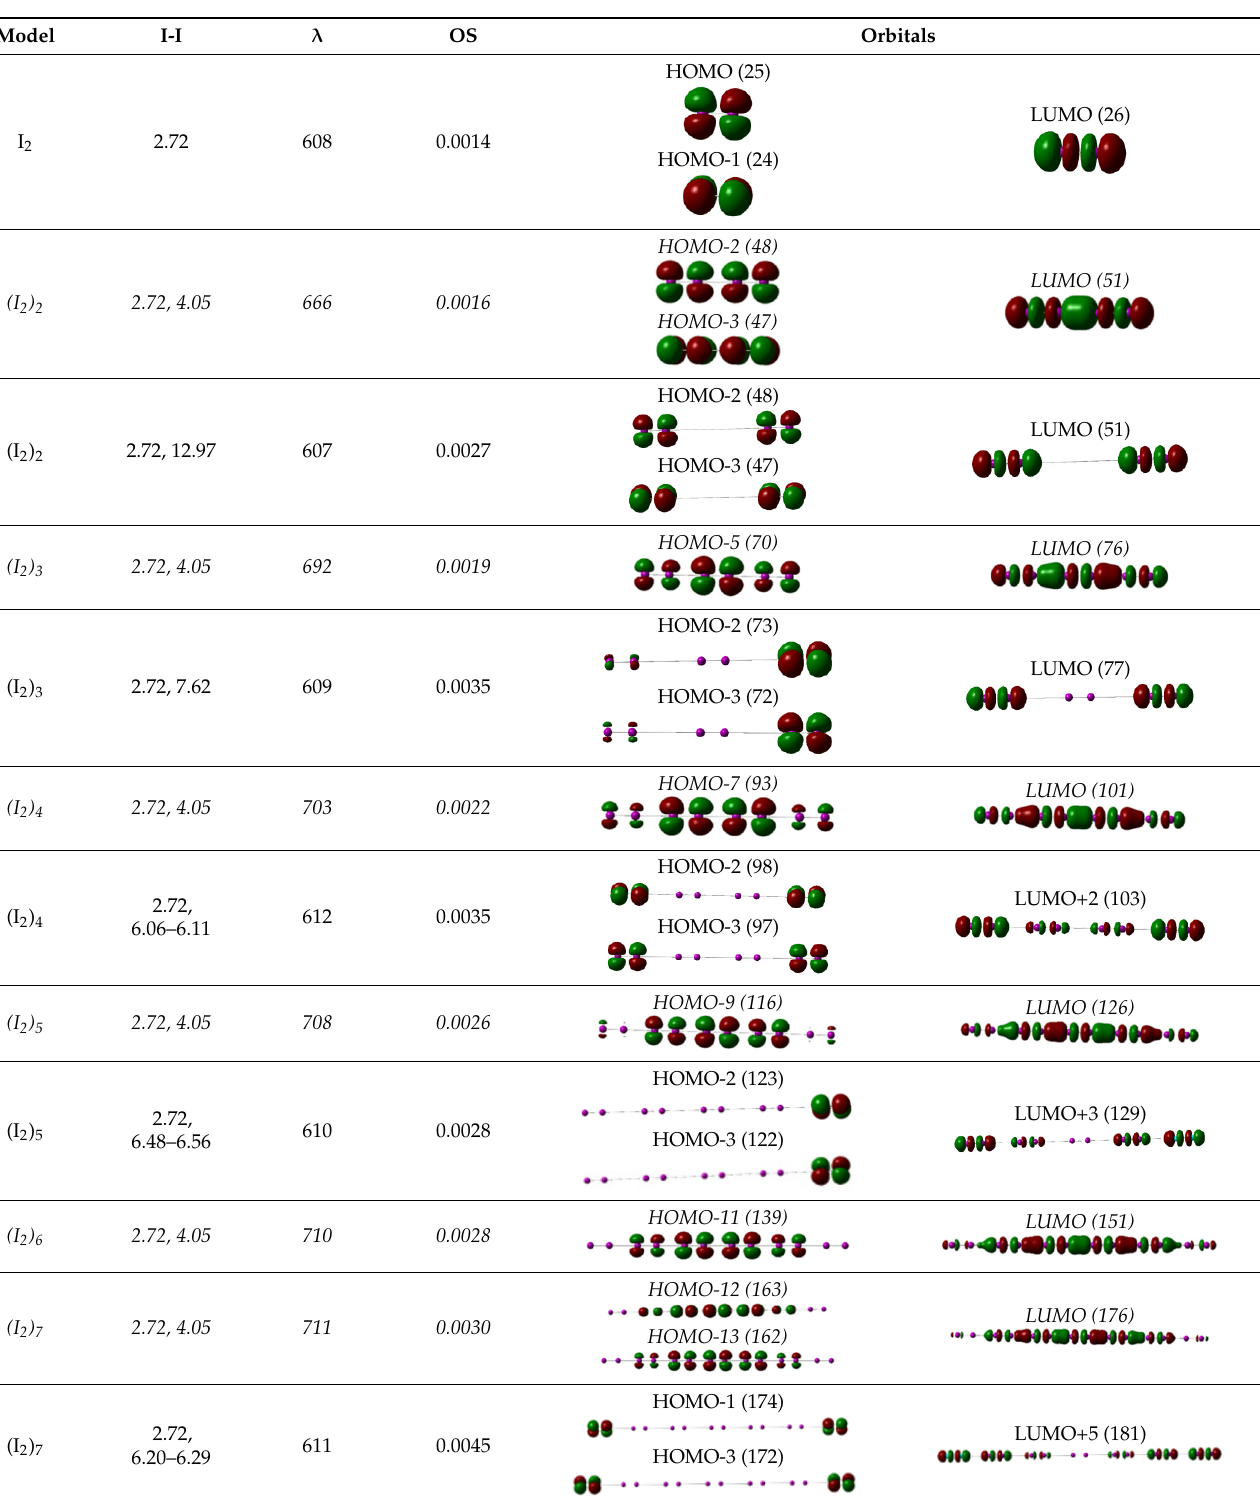
Table 1. I-I distances (Å), wavelengths ( λ , nm), oscillator strengths (OS), and relevant molecular orbitals for the largest visible maxima of linear I 2 models (TD-DFT, B3LYP/def2-SV(P)). Data in italics are from energy calculations on structures with 2.72 Å I-I distances (known experimentally for I 2 in solid state, identical to the those obtained upon DFT optimization of a single I 2 molecule),[57] and with I 2 -I 2 distances arbitrarily set at the limit of the sum of van der Waals radii (4.05 Å). All other data are from optimized geometries.